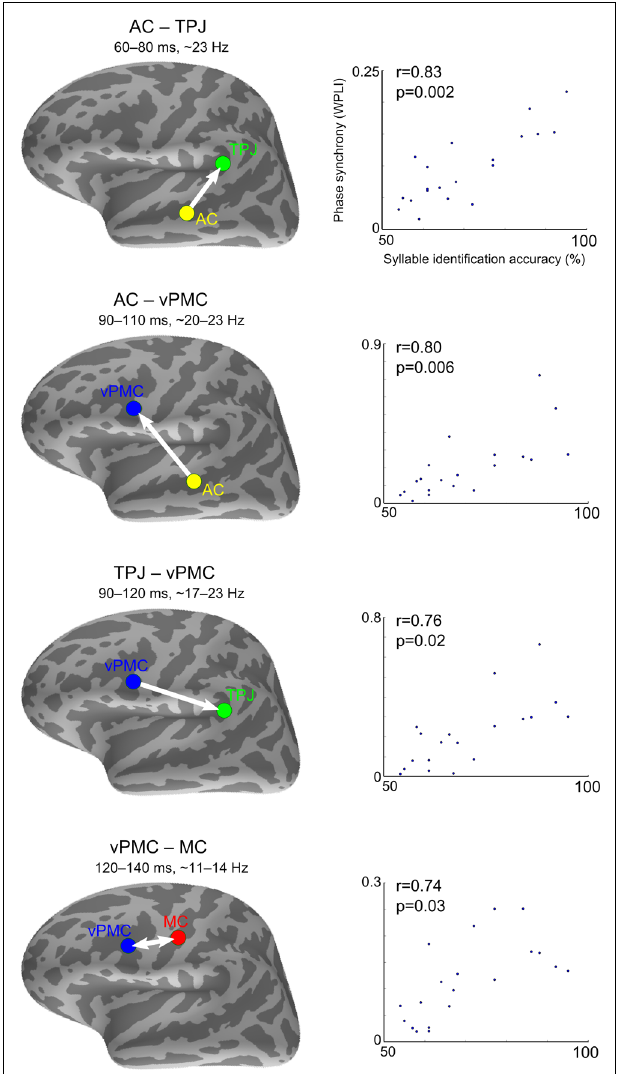
FIGURE 4 | Correlations between inter-areal phase synchrony and syllable identification accuracy. Syllable identification scores plotted against phase synchrony strength (WPLI) at the time-frequency point of strongest correlation.The spearman rank correlation coefficients ( r ) and corresponding p -values are denoted in each plot.The arrows indicate SEM-derived directionality effects based on the pairwise path coefficients. The double arrow denotes undirected interaction. AC, auditory cortex;TPJ, temporoparietal junction; vPMC, ventral premotor cortex; MC, motor cortex.